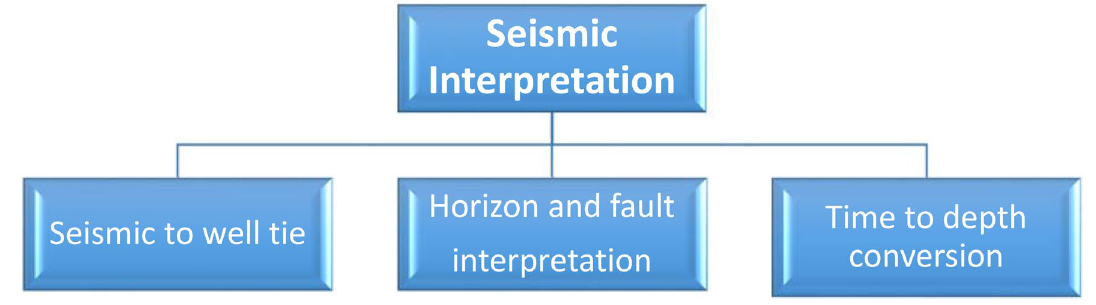
Fig. 8 A sketch showing the seismic interpretation workflow starting with the seismic to well tie, horizon and fault interpretation, and time to depth